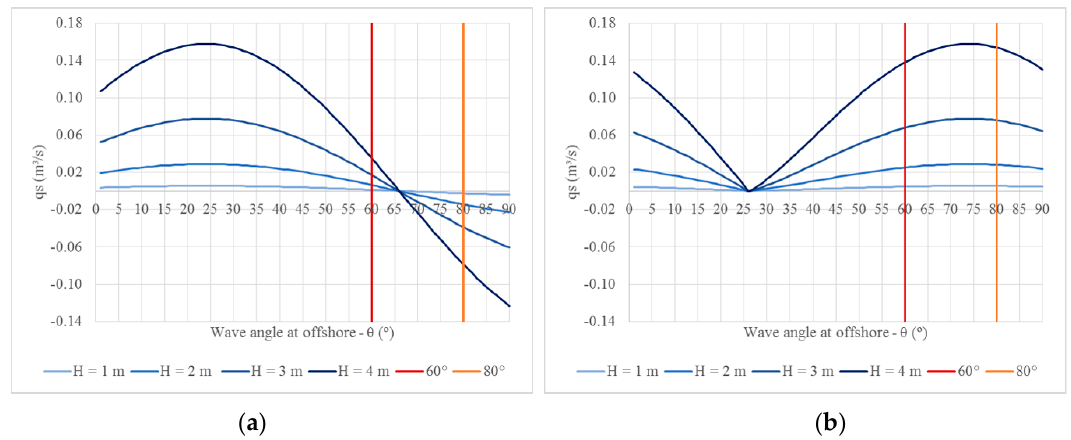
Figure 4. Longshore sediment transport rate according to CERC formula for different wave heights in function of the wave angle at offshore: Δθ = +25° ( a ); Δθ = − 25° ( b ).